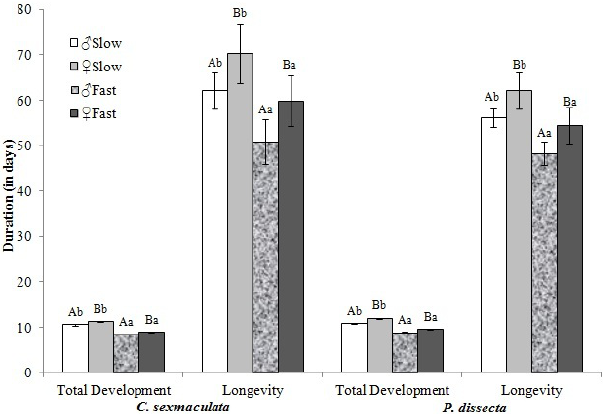
Figure 3. Total developmental duration and longevity of slow and fast developers in C. sexmaculata and P. dissecta . Alphabets in up- per case denote comparison between di ff erent sexes (male and fe- male) of a developmental group (i.e. either slow or fast) within a species. Alphabets in lower case denote comparison between same sexes (either males or females) of the two di ff erent developmental groups (slow and fast) within a species. Similar numbers or alpha- bets denote lack of significance at P > 0 .